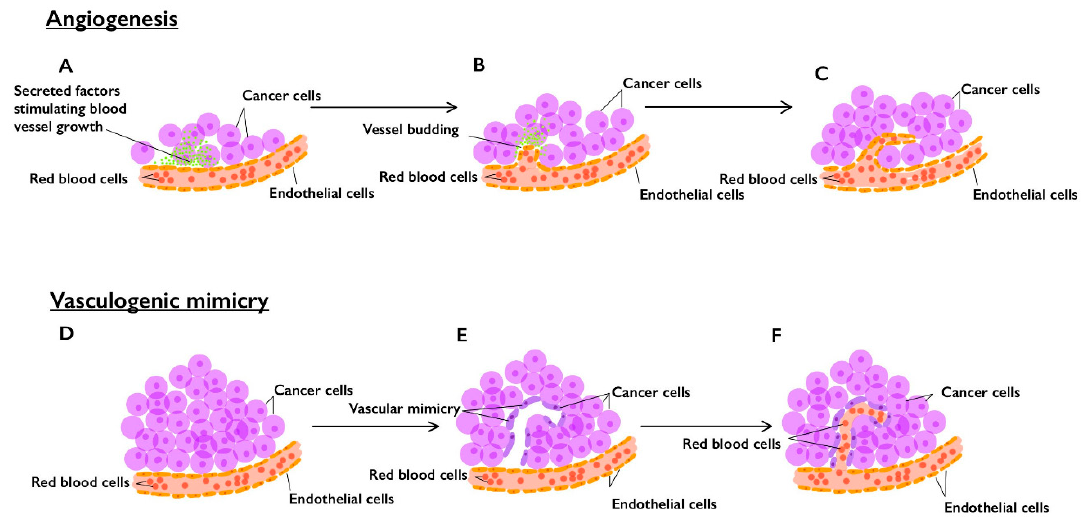
Figure 2. Angiogenesis versus vasculogenic mimicry (VM) in the tumorigenesis of solid tumors. In angiogenesis: ( A ) tumor cells secrete potent angiogenic factors; ( B ) these factors enhance the budding and growth of pre-existing blood vessels; ( C ) new endothelial cell-lined blood vessels are formed and enrich the tumor microenvironment. In VM: ( D ) aggressive starved tumor cells can utilize an alternative non-angiogenic vascularization method; ( E ) tumor cells start to generate new patterned vessel-like anastomoses; ( F ) these new tumor cell-lined channels invade host vessels and increase nutrient retrieval to nourish tumor tissue.